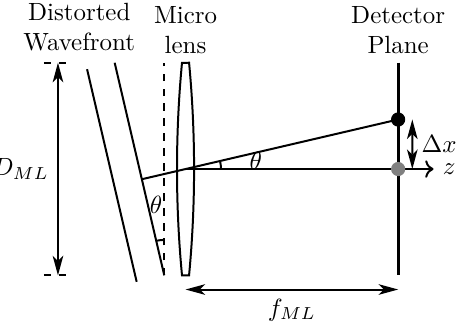
Figure 1. Schematic of a single micro lens in the Shack–Hartmann wavefront